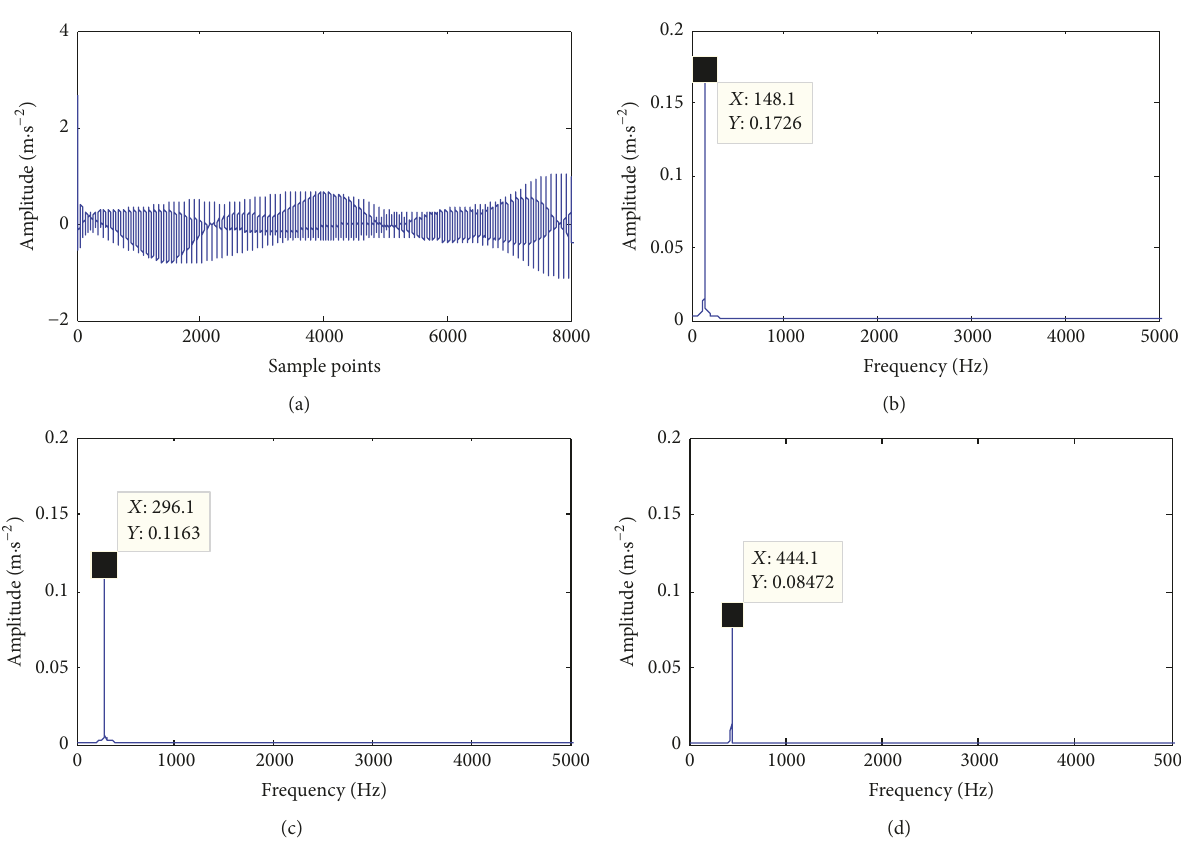
Figure 15: (a) The synthesized signal by AMD method and (b–d) the three IMFs of experimental signal with VMD decomposition.